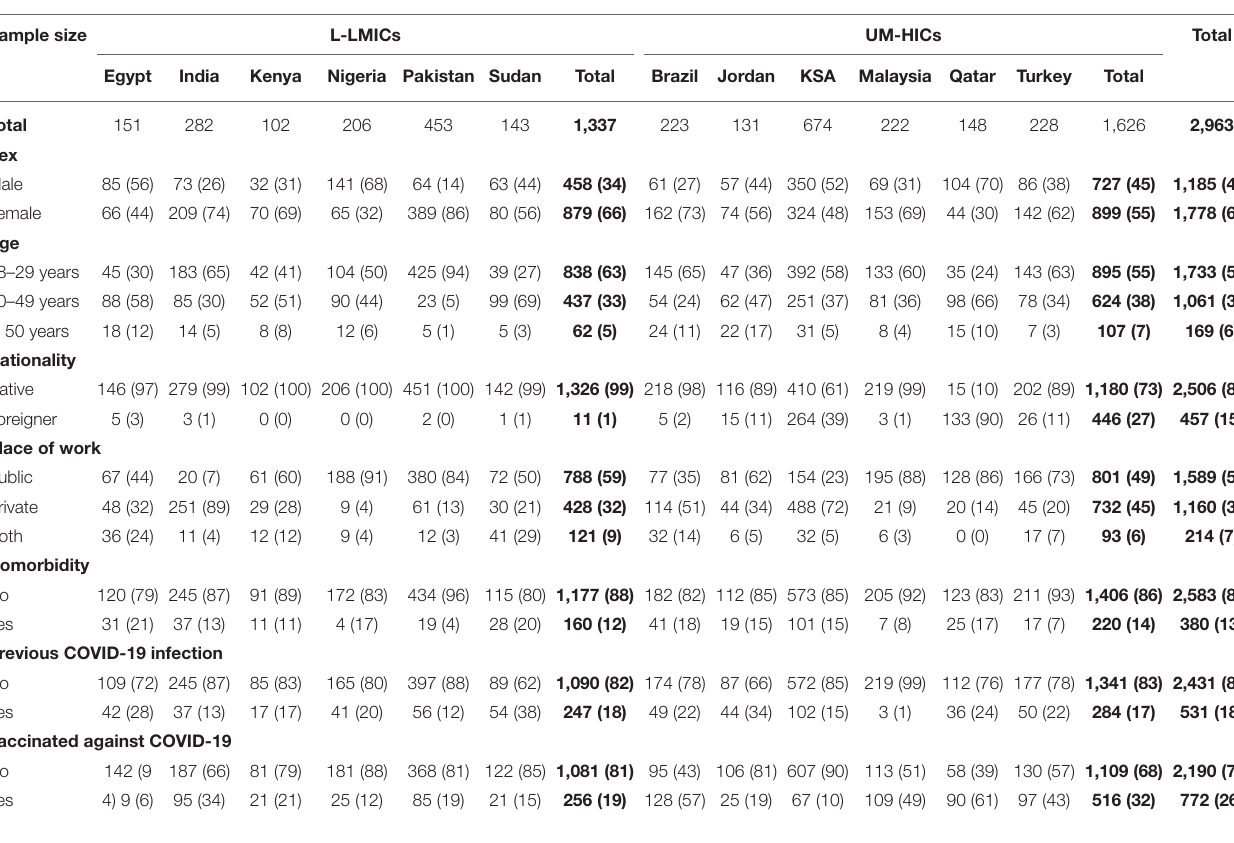
TABLE 1 | Sample characteristics: Data are presented as n